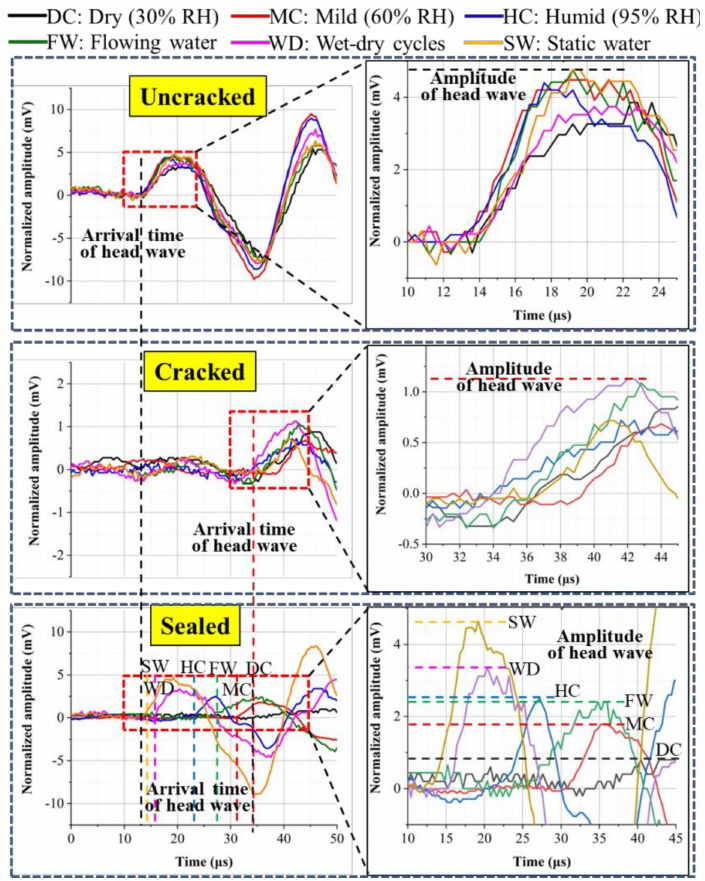
Figure 8. Arrival time and amplitude of head waves for the samples cured in different conditions.